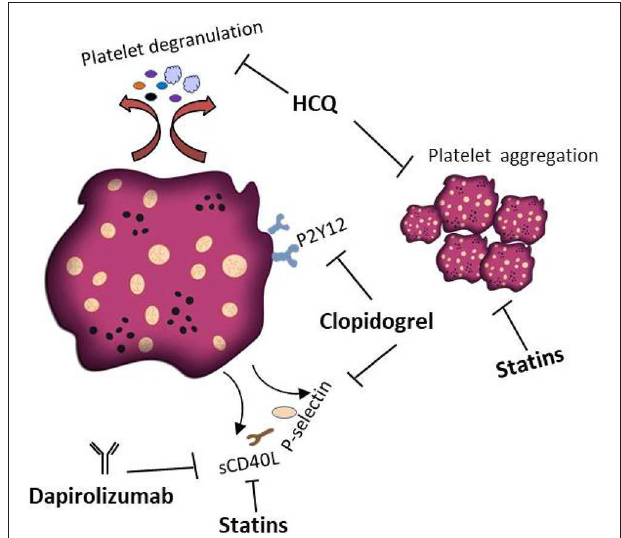
in skin autoimmune diseases have been proposed. HCQ inhibits platelet aggregation and degranulation. Clopidogrel is a P2Y12 receptor inhibitor preventing the release of platelet derived sCD40L and P-selectin. Dapirolizumab is a monoclonal antibody specifically blocking sCD40L functions. Statins are supposed to affect the thrombotic activities of platelets and to decrease the plasma levels of